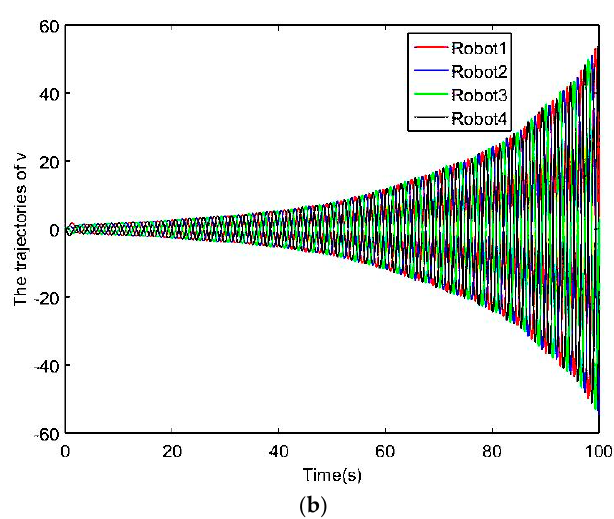
Figure 6. Experiment 2 Group 2 simulation results; x is position, v is velocity. ( a ) Trajectory of x changing with time; ( b ) Trajectory of v changing with time.